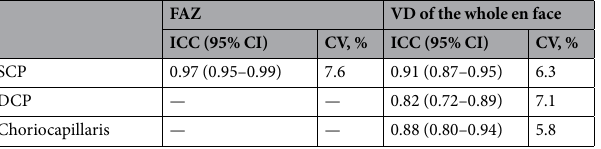
Table 6. Intraobserver repeatability of measurements of vessel density with OCT angiography in the SCP, DCP and